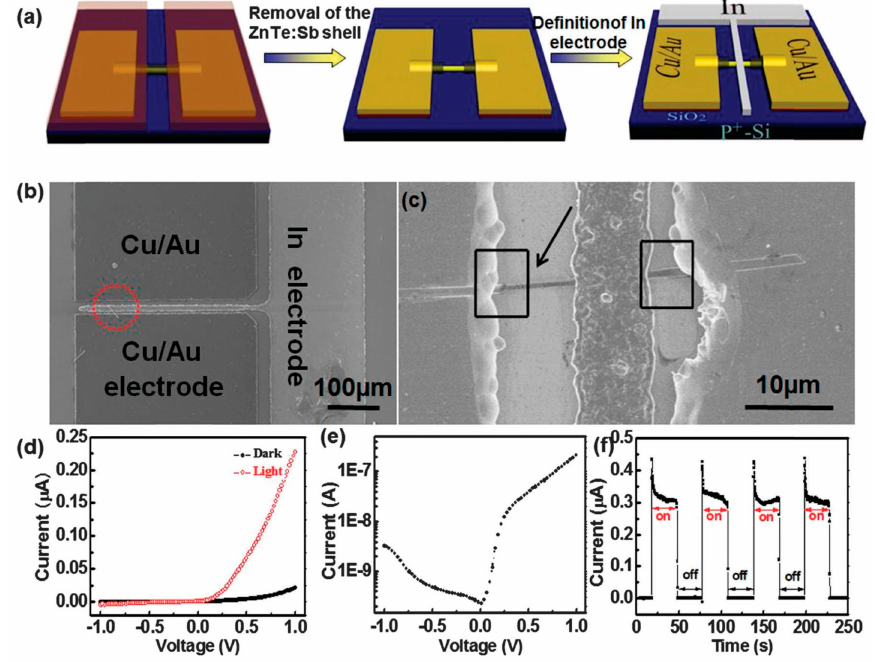
Figure 14. ( a ) Stepwise process for the fabrication of a single CdS:Ga-ZnTe:Sb nanostructures. ( b , c ) Representative FESEM images of a p-n junction device. ( d ) Rectification characteristics of the p-n junction measured both in the dark and under light illumination. ( e ) I-V curve of the p-n junction under light illumination at a log scale. ( f ) Photoresponse of the CdS:Ga-ZnTe:Sb nanostructures to the pulsed light illumination, and the bias voltage is 1 V. Reproduced with permission from [29], Copyright 2011, The Royal Society of Chemistry.